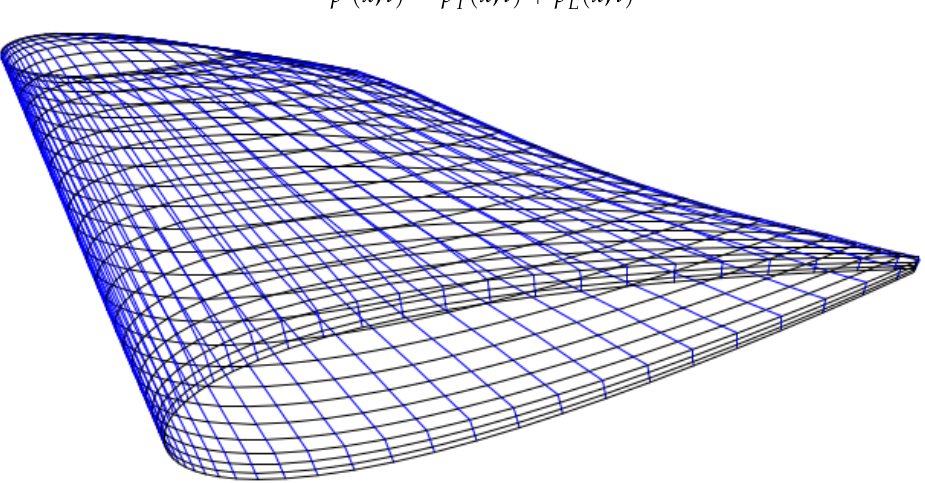
Figure 1. Example of a wing surface